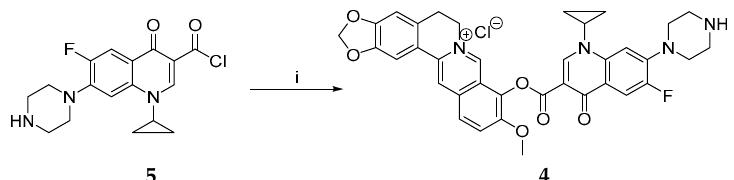
Scheme 5. Synthesis of berberine derivative 4 . Reagents and conditions: (i) berberrubine, NaH, dioxane, 300 W, 100 °C, 10 min.